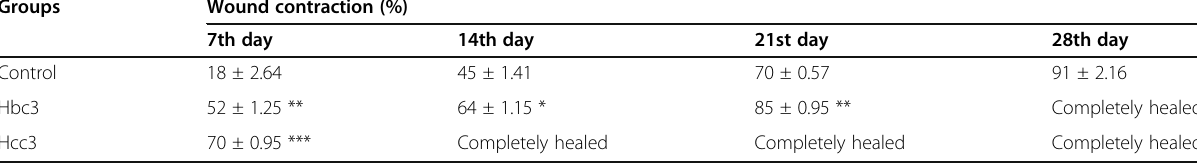
Table 3 Percentage of wound contraction at different time intervals in different groups Groups